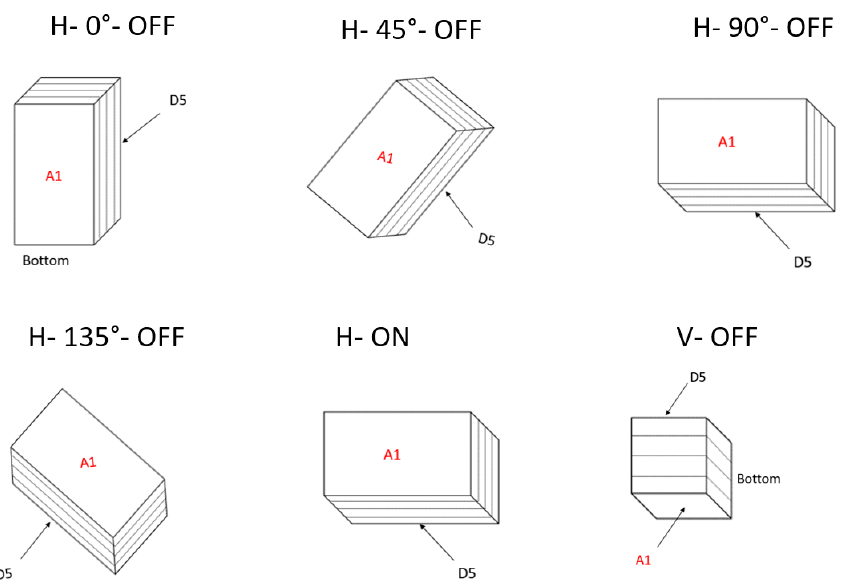
Figure 5. Top view of gellan gel samples in different orientations. The abbreviations of V, H, ON, and OFF represent vertical orientation, horizontal orientation, turntable on, and turntable off, re- spectively.